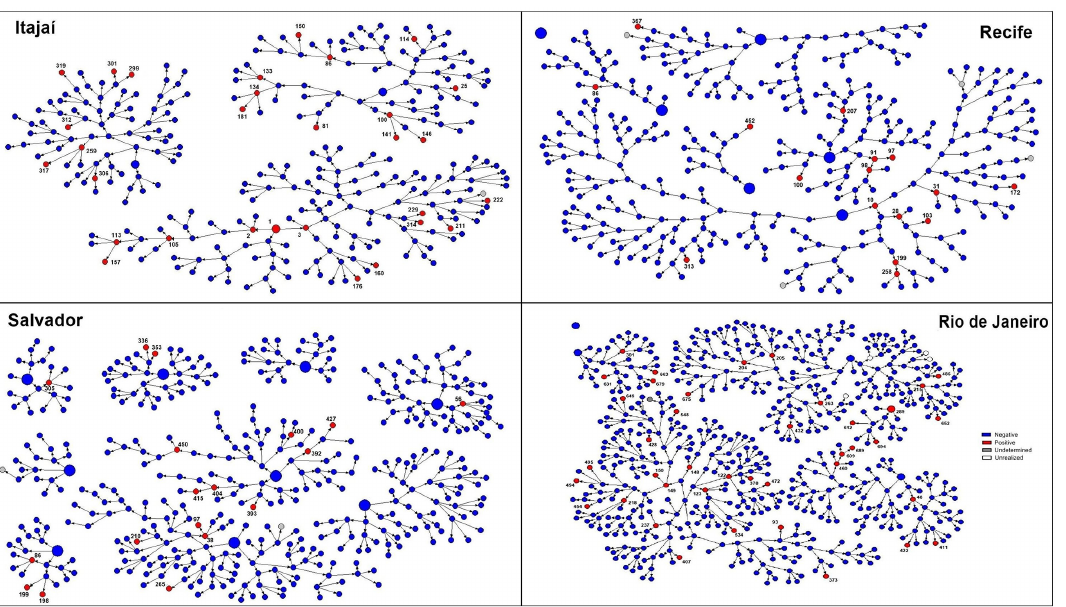
Fig 4. Schematic representation of responded driven sampling (RDS) recruitment network from Itajaí (SC), Recife (PE), Salvador (BA) e Rio de Janeiro (RJ), places were the phylogenetic cluster were detected. Large circles represent the first recruited individual in each network, designated as seeds and small circles represent the consecutive waves of recruitment. HIV-1 positive individuals were colored in red, HIV-1 negative individuals in blue and individuals not tested for HIV in gray. The numbers were depicted only in HIV-1 positive individuals and were related to the sequence numbers (e.g. individual marked as number 1 in Itajai RDS representation corresponds to the RDSSC001